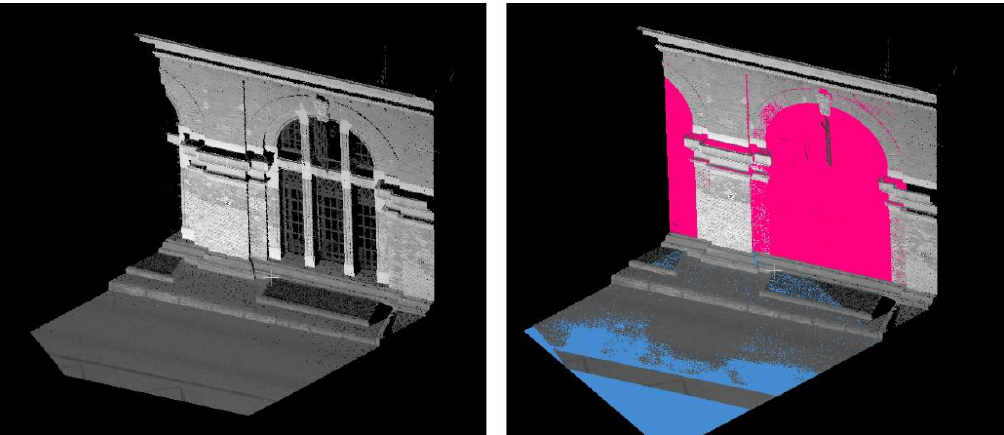
Fig. 1. Results of searching for planes for a building.